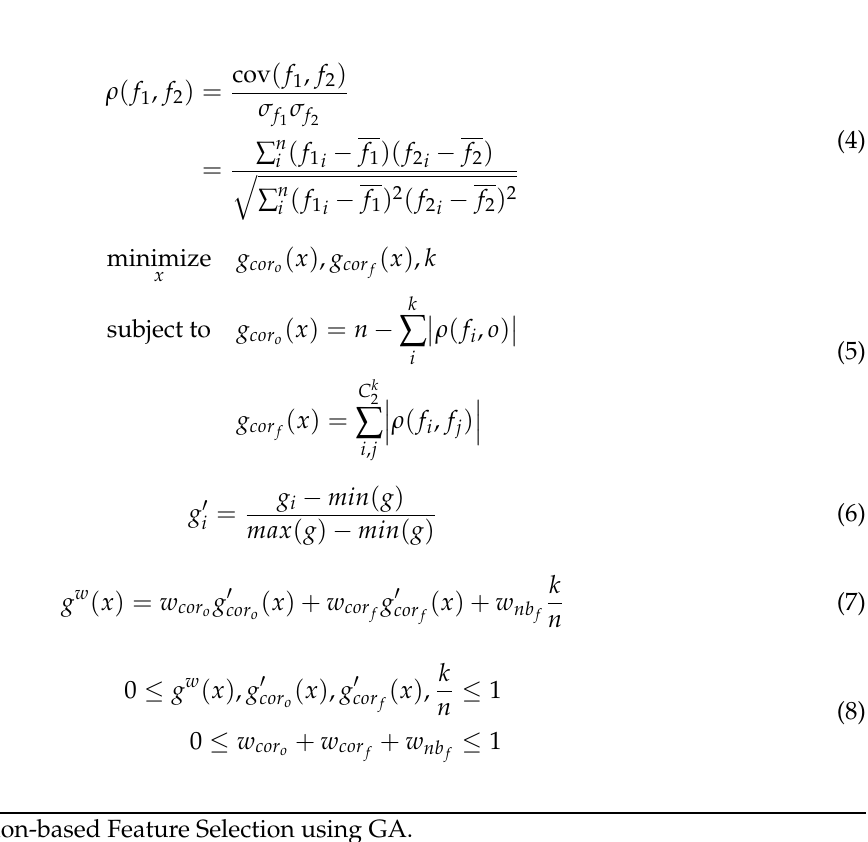
Algorithm 2 Correlation-based Feature Selection using